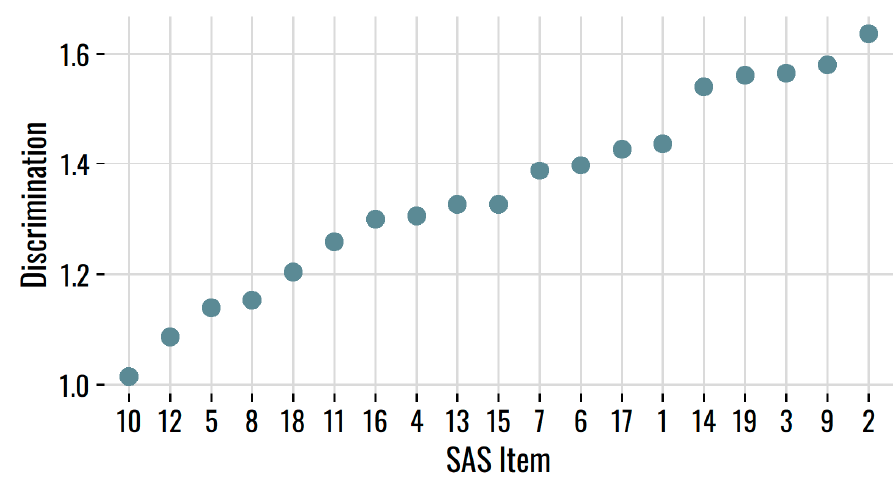
Figure 2. Item difficulty ( b , top panel ) and discrimination ( a , bottom panel ) values from the 2PL model, sorted from low to high.